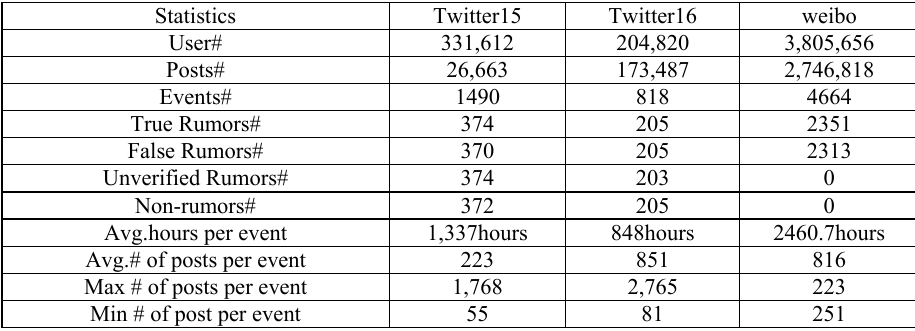
Table 1. The statistical data of three data sets.